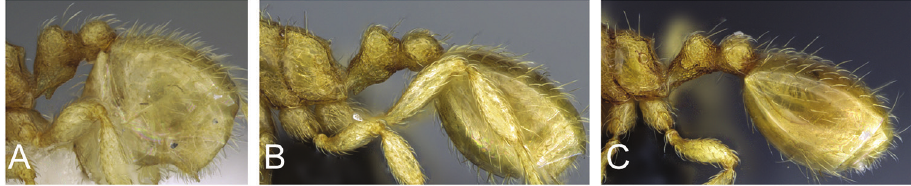
Figure 30. Mesosoma, petiole, postpetiole and gaster in profile view of A Carebara hainteny (CASENT0410542) B Carebara vazimba (CASENT0055533) C Carebara sampi